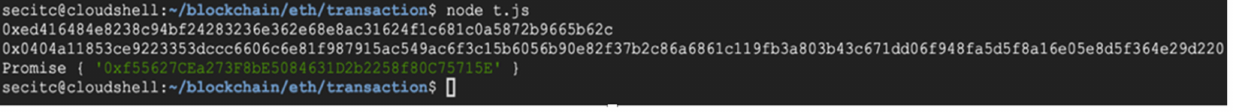
Figure 7. Ethereum Address generation